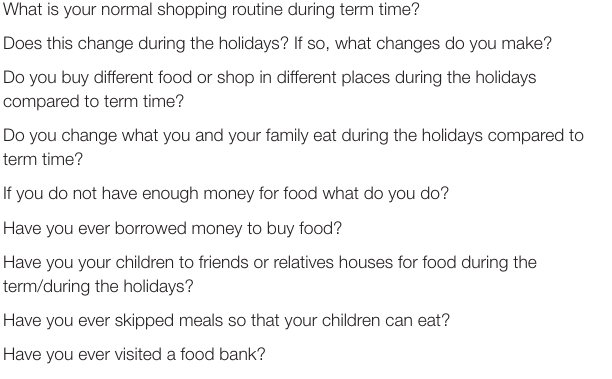
TABLE 3 | Schedule of